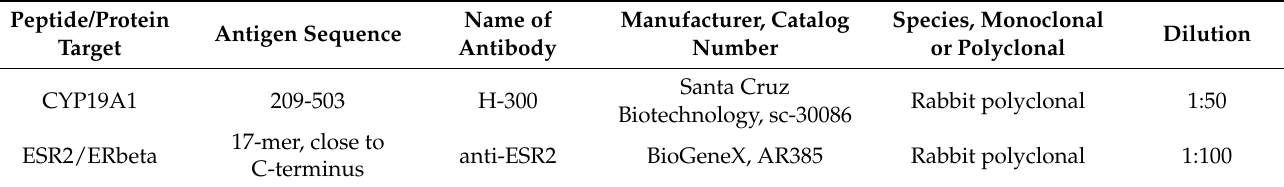
Table 1. Antibodies used in this